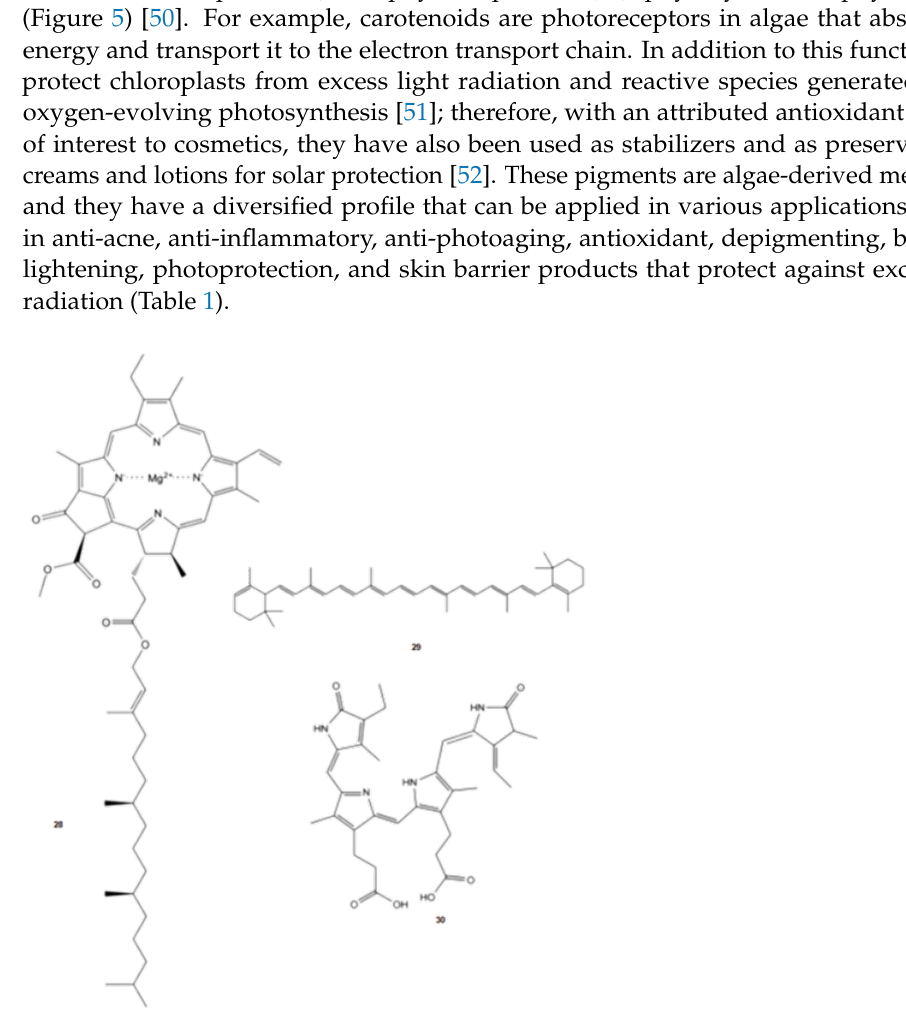
Figure 5. Pigments from macroalgae.